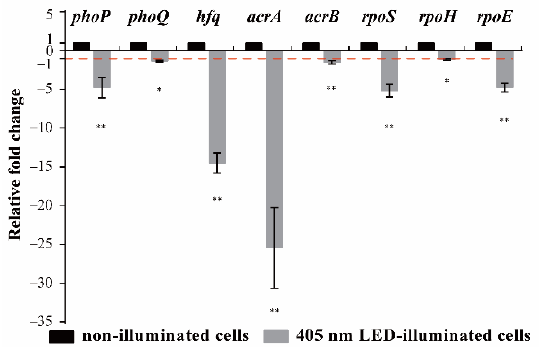
Figure 8. Transcription levels of S . Typhimurium environmental tolerance-associated genes. * p < 0.05, ** p < 0.01 vs. non-illuminated cells.